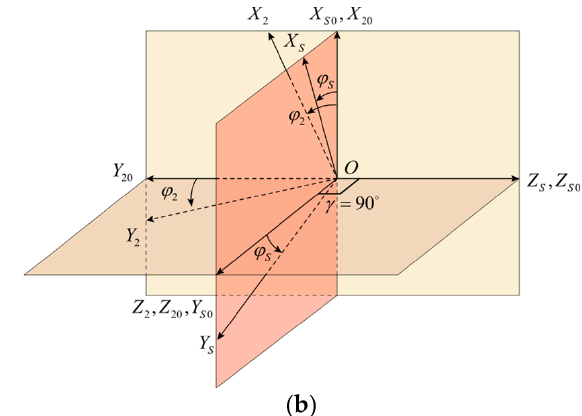
Figure 1. Schematic diagram of the concentric face gear split-torque transmission system.